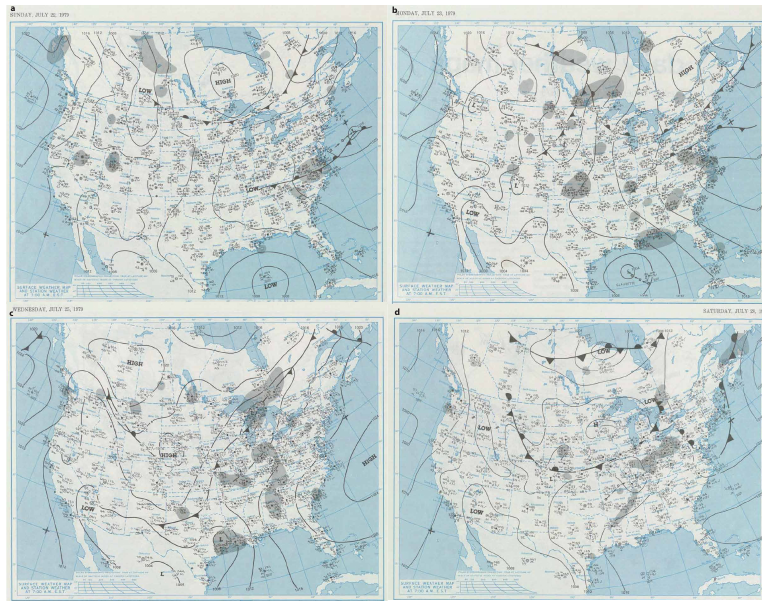
Figure 2. Daily weather maps for Hurricane Claudette, 1979. ( a ) Sunday, 22 July, a low pressure zone moves in from the Gulf of Mexico. ( b ) Storm officially named Claudette. ( c ) Rainfall occurs for next three days. ( d ) The low pressure center leaves and stops bringing rain to Southeast